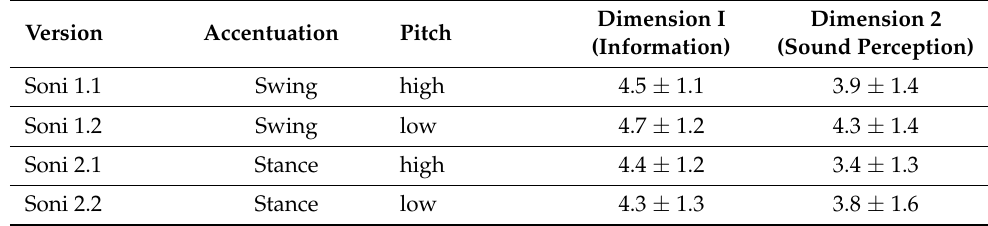
Table 2. Ratings (mean ± SD) for the four feedback versions (Soni 1.1–Soni 2.2) in the two dimen- sions on a Likert scale of 1–6 ( N = 28 participants).